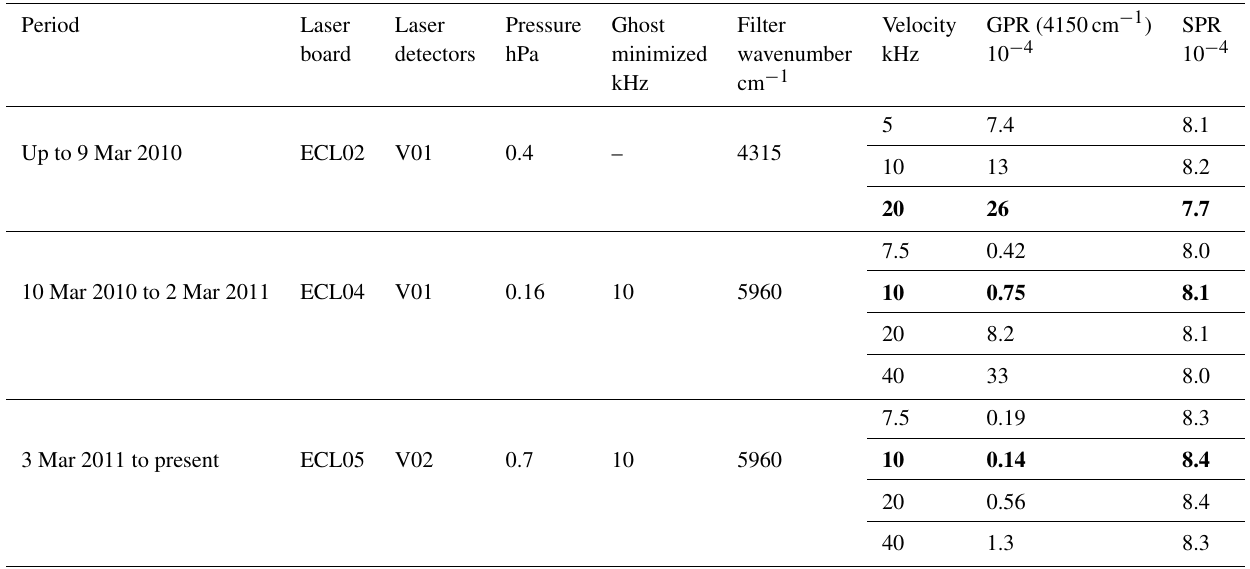
Table 2. Laser board settings and measurements. Ghost-to-parent intensity ratio (GPR) and the ratio of the spurious signal to primary signal intensity (SPR) are shown at different scanner velocities. The used scanner velocities and the corresponding GPR and SPR values are shown in bold. Period Laser Laser Pressure Ghost Filter Velocity GPR (4150cm − 1 ) SPR board detectors hPa minimized wavenumber kHz 10 − 4 10 − 4 kHz cm − 1